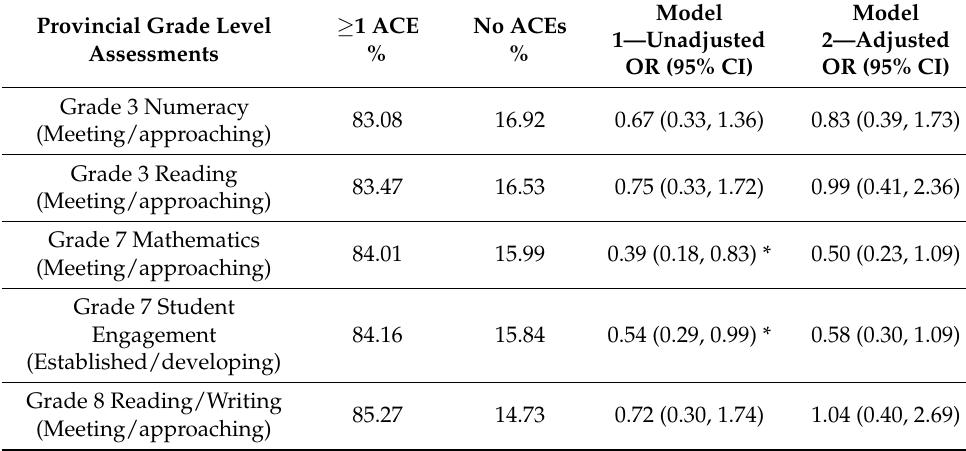
Table 3. Odds of education outcomes on provincial assessments for adolescents with at least one ACE compared with adolescents with no